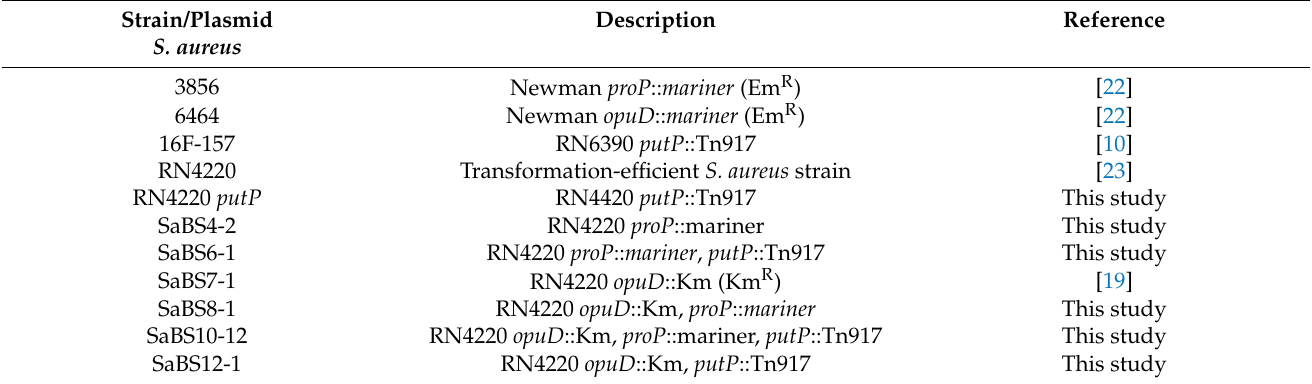
Table 1. Bacterial strains used in the